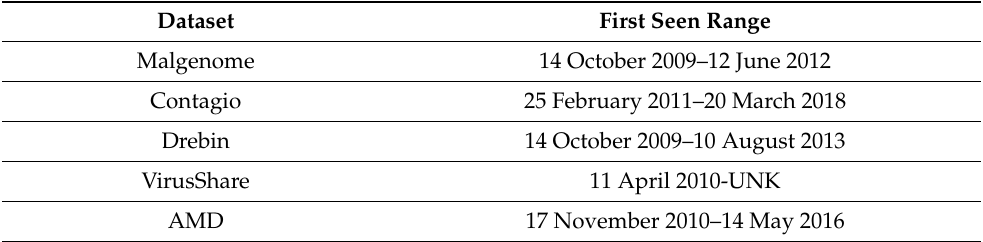
Table 4. Date ranges for the samples of well-known